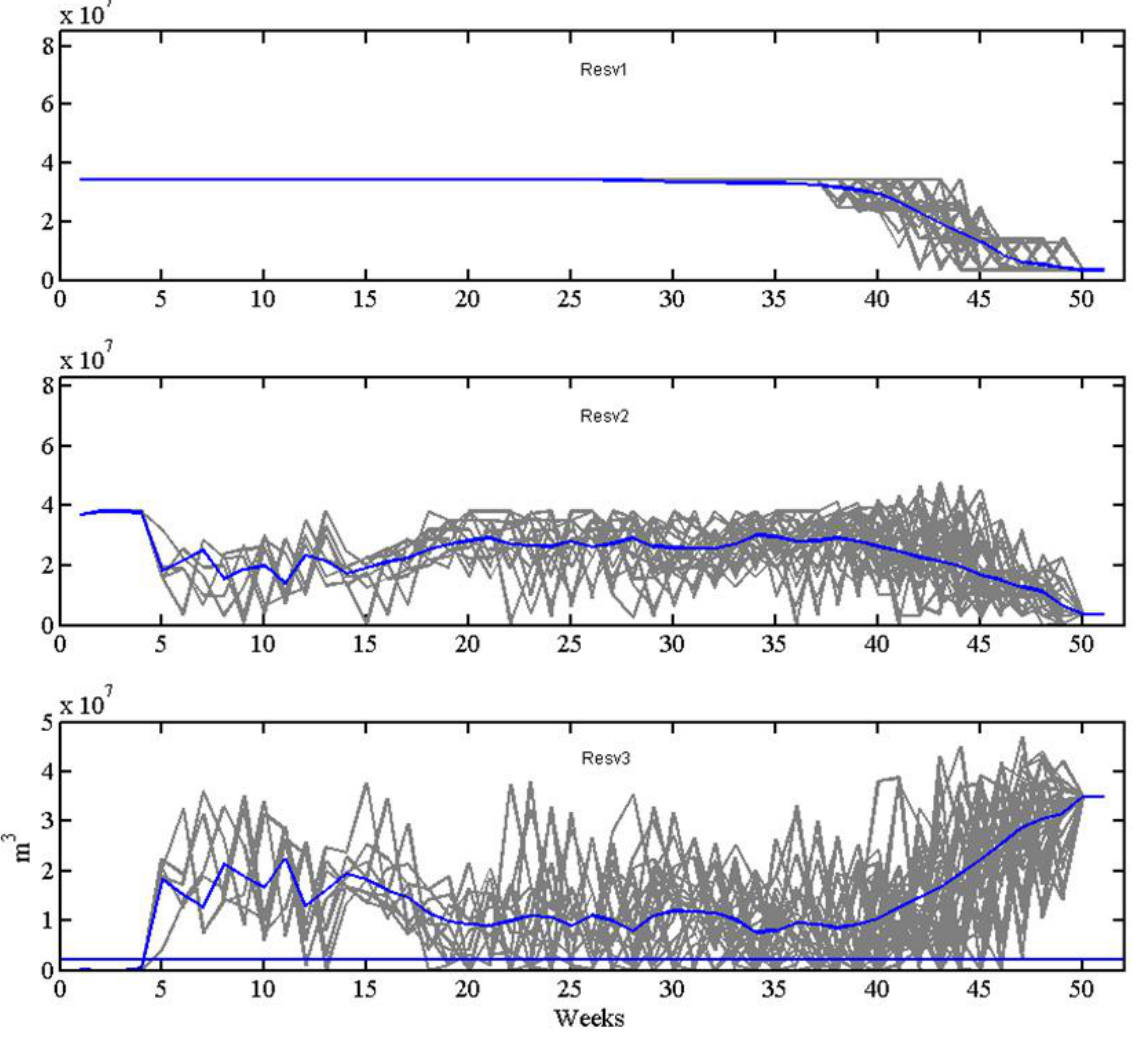
Fig. 8. Reservoir storage level scenarios and decision